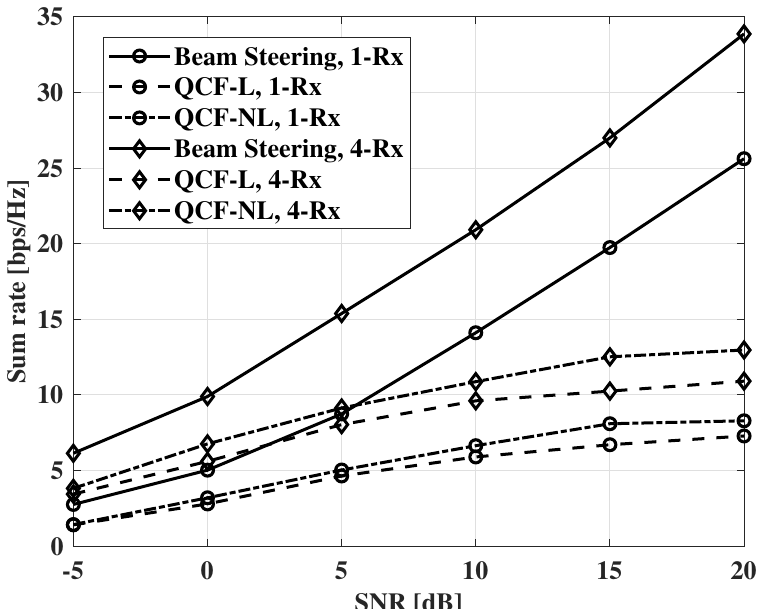
Figure 8. Sum rate measurements according to SNR, codebook size = 8 bits, N t = 32, N RF = 4, and N r = 1,4.